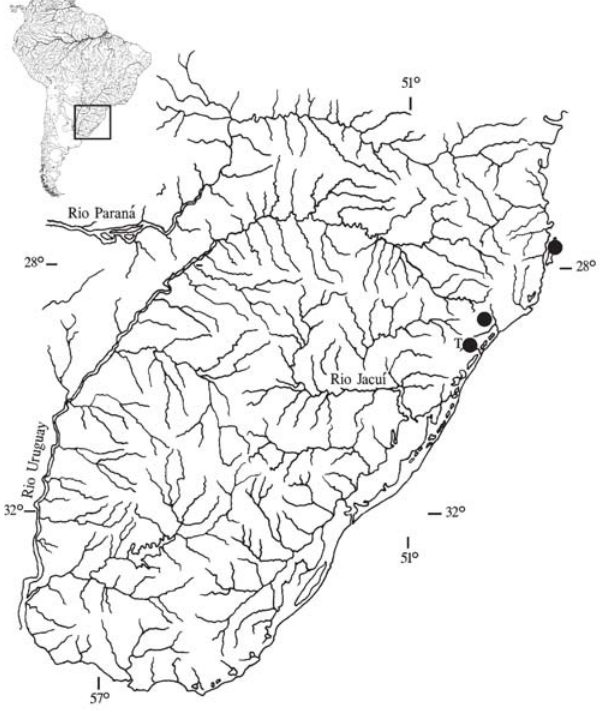
Fig. 4. Geographic distribution of Scleromystax salmacis . T =